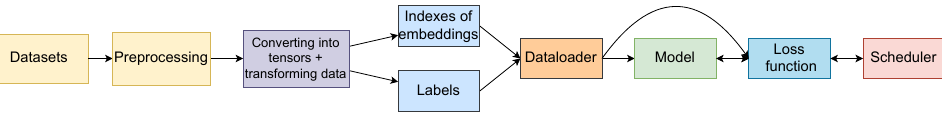
Figure 4. High-level architecture of the testing